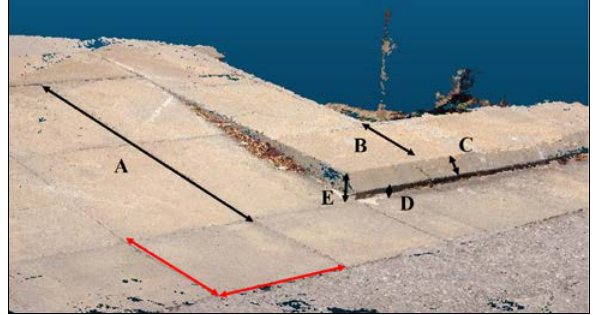
Figure 7. Curb ramp scenario. 3D reconstructed point cloud along with reference targets. The measurements used to compute the point cloud are represented in red, while the reference measurements used to check the relative accuracy of the point cloud are represented in black.